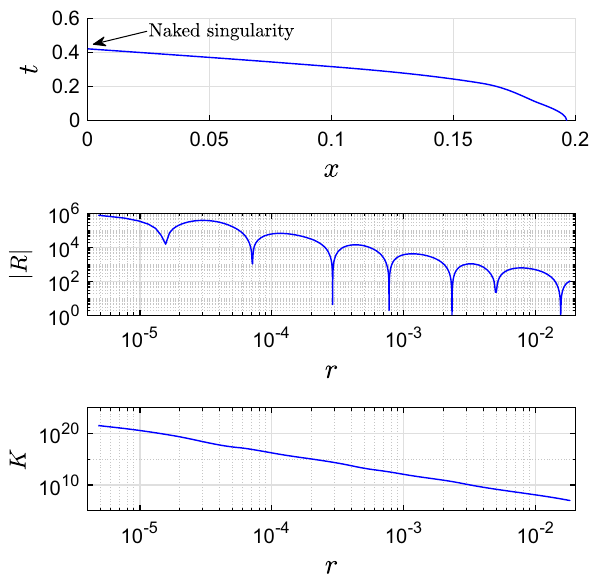
Fig. 3 Resultsonthestrengthofthesingularity.Upperpanel:thenorm of the volume element || V || ( = | b | p 2 r 2 ) along the geodesic approach- ing the singularity. Middle and lower panels: φ and 8 π(φ ,λ ) 2 [= τ 2 R αβ T α T β ] vs. λ( ≡ − ln τ) along the